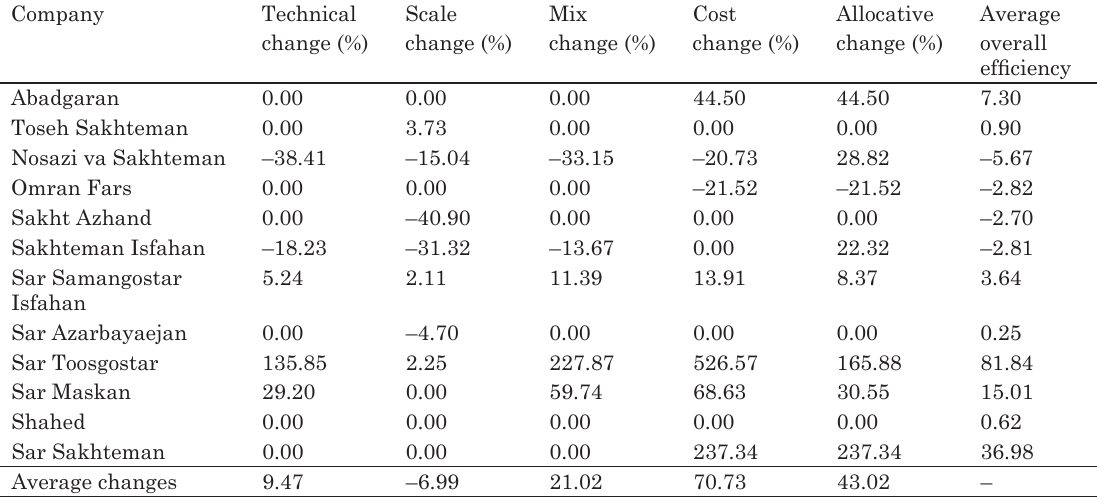
Table 4. Sensitivity analysis on efficiencies for each company